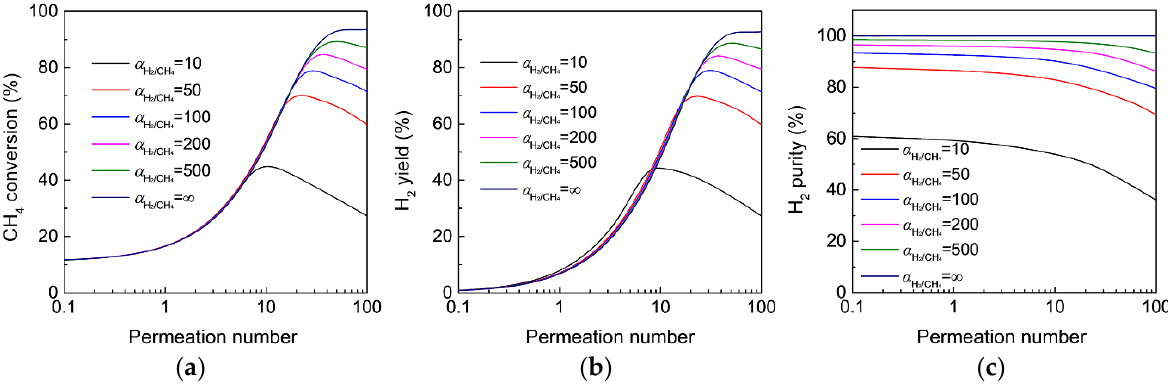
Figure 5. Effect of H 2 /CH 4 selectivity on ( a ) CH 4 conversion, ( b ) H 2 yield, and ( c ) H 2 purity as a function of permeation number for MDA in the membrane reactor. (Simulation conditions: T = 973 K, Da = 5, = Knudsen selectivity, p h = 1 bar, p l = 0.05 bar).